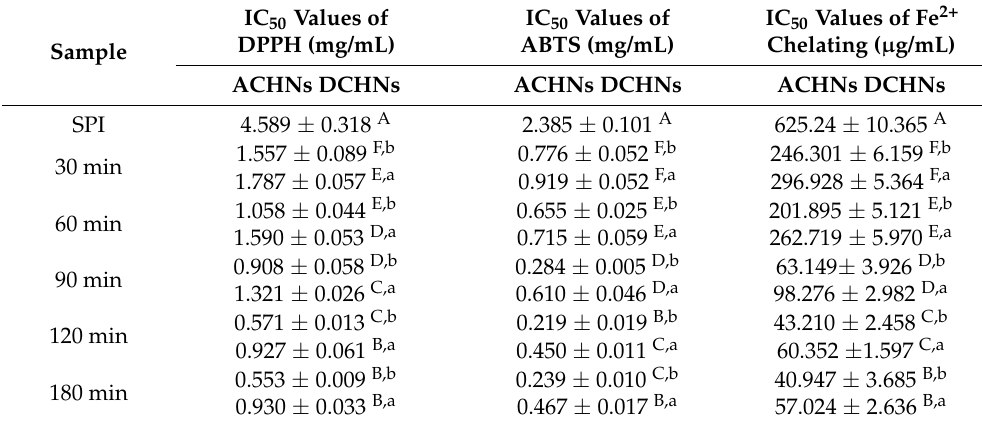
Table 2. IC 50 values of the antioxidant activities of SPI and SPHs.